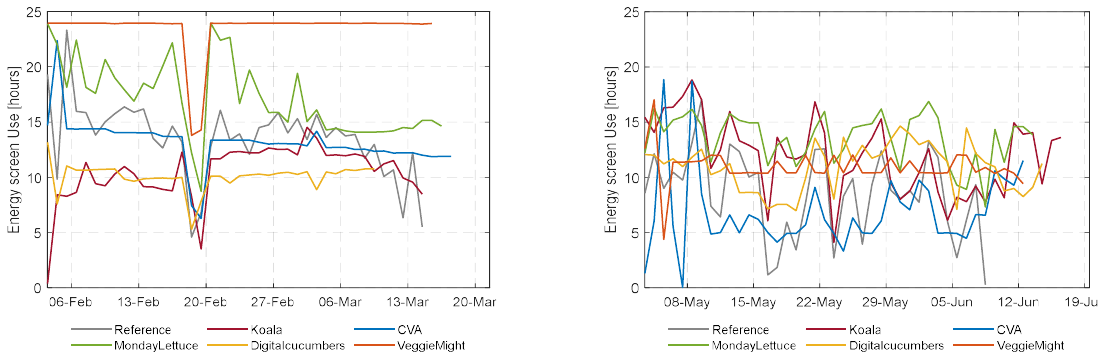
Figure A2. Energy screen usage in all compartments during the first and second cultivation.